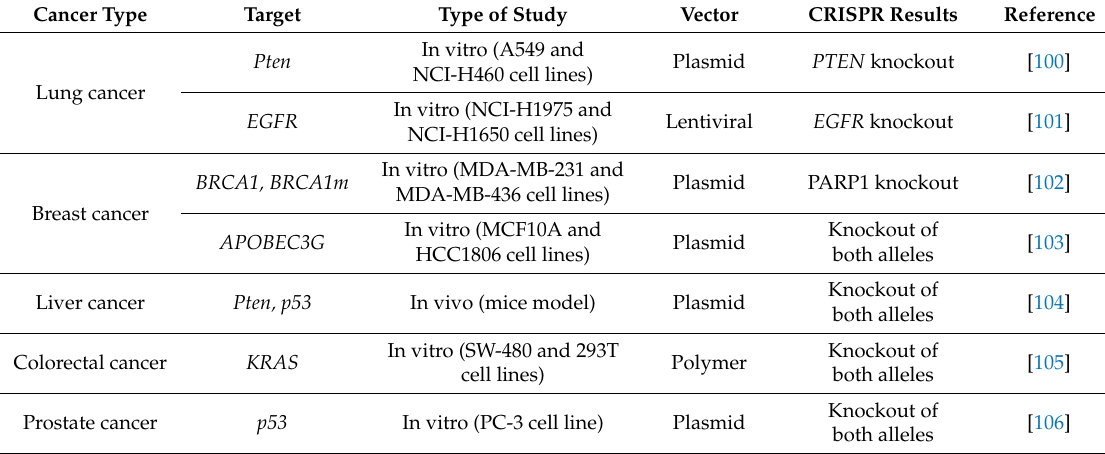
Table 4. CRISPR–Cas9 applications in the di ff erent types of cancer